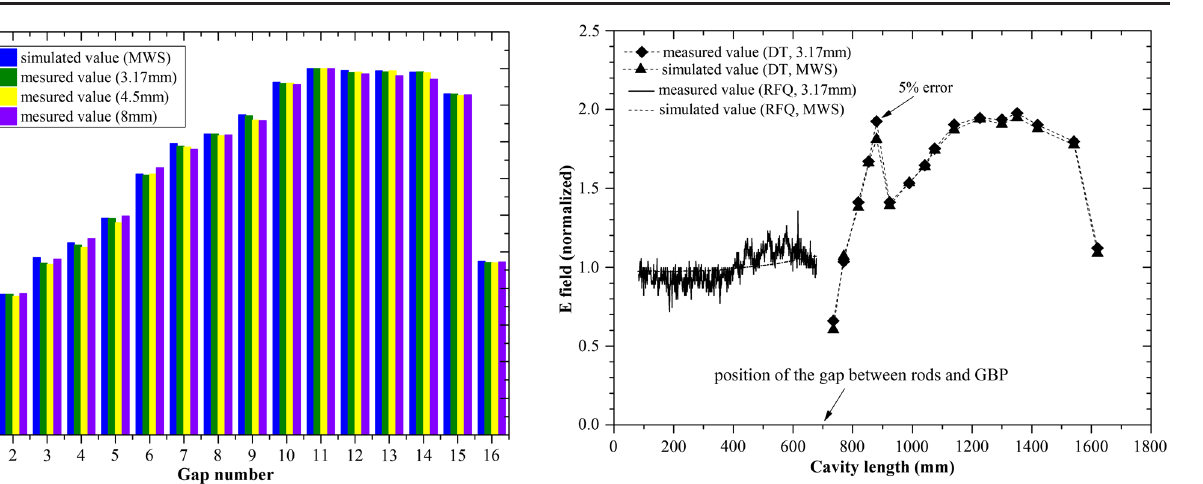
FIG. 3. Simulated and measured E field strengths along the beam axis in the DT section. The largest measured E field of the each measurement during the test was normalized to 1.